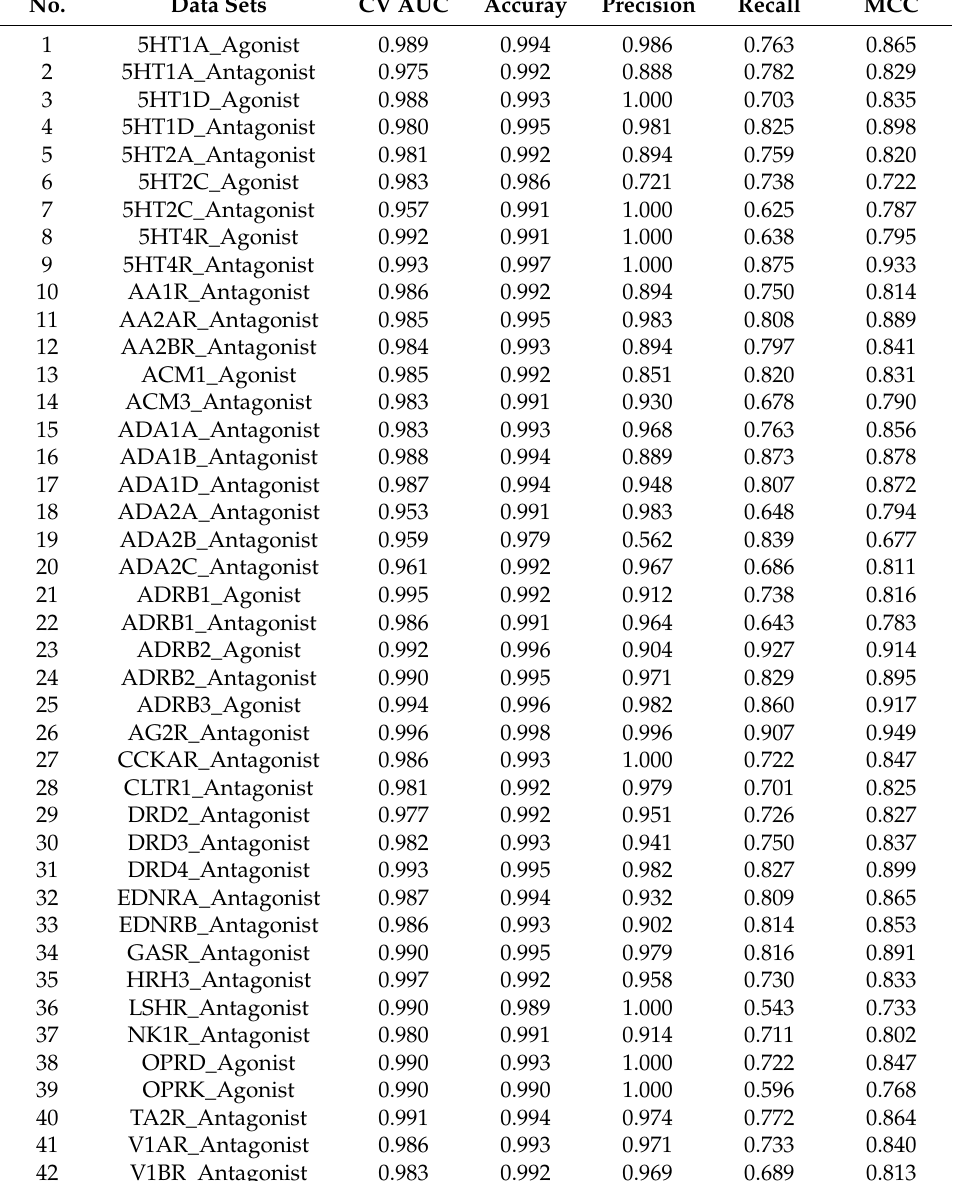
Table 1. Results of the discriminant models for the 42 GLL/GDD (G protein-coupled receptor (GPCR) ligand library and the GPCR decoy database) data sets. Models were built with the “weighted” method for handling the data imbalance. The CV AUC is a 10-fold cross-validation result of the training set. Accuracy , Precision , Recall , and MCC are the prediction results for the test set. Results of the other two treatments for data imbalance can be found in Supplementary Materials Table